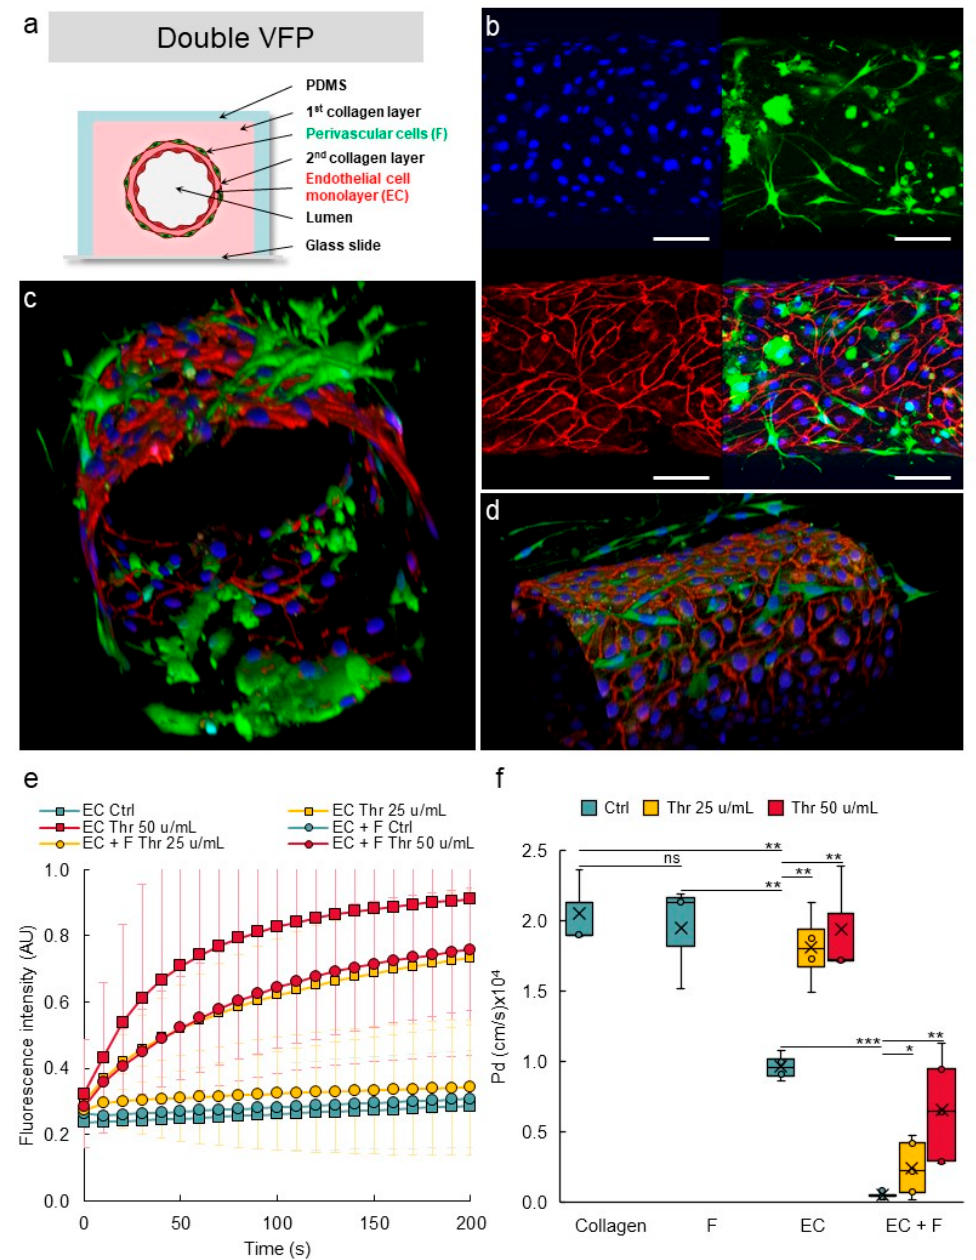
Figure 10. Design of multilayered VoC. ( a ) Principle of multilayer VoC construction using